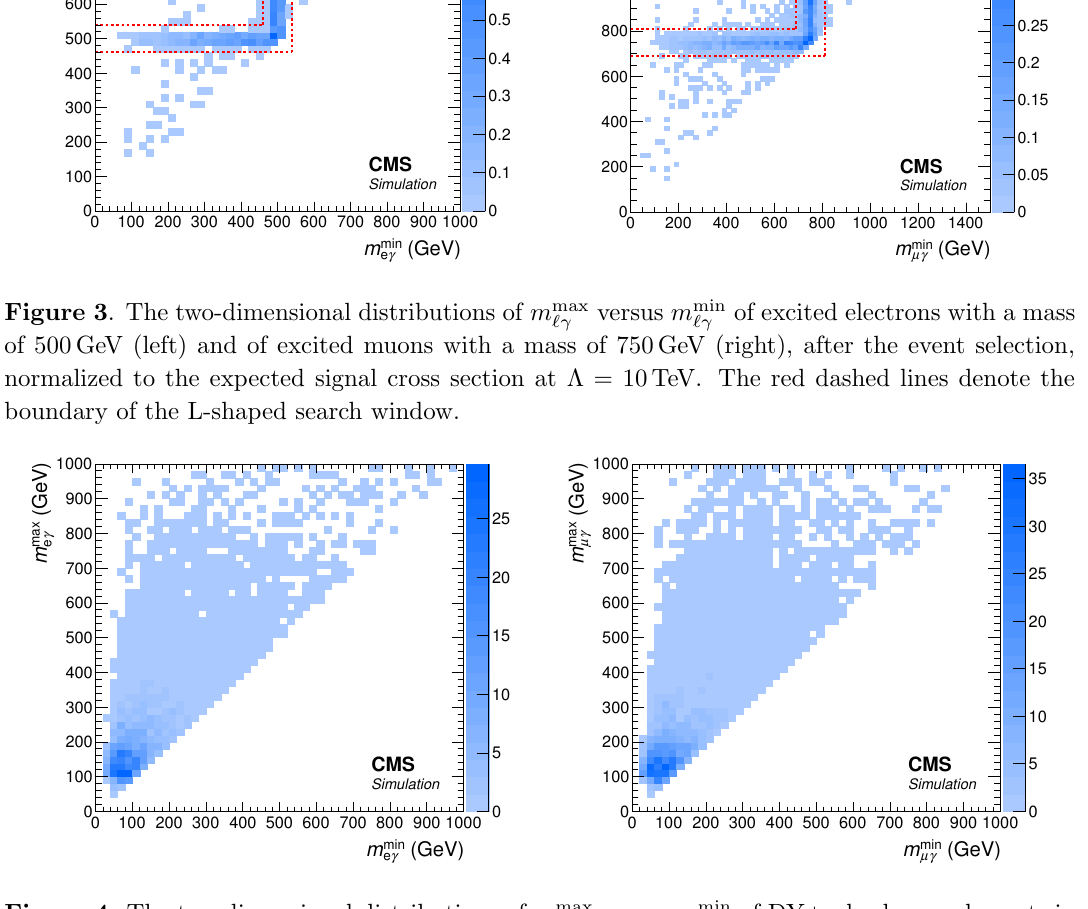
Figure 4 . The two-dimensional distributions of m max the ee (cid:13) (left) and (cid:22)(cid:22)(cid:13) (right) channels, after the event selection, normalized to the cross section for DY+ (cid:13)